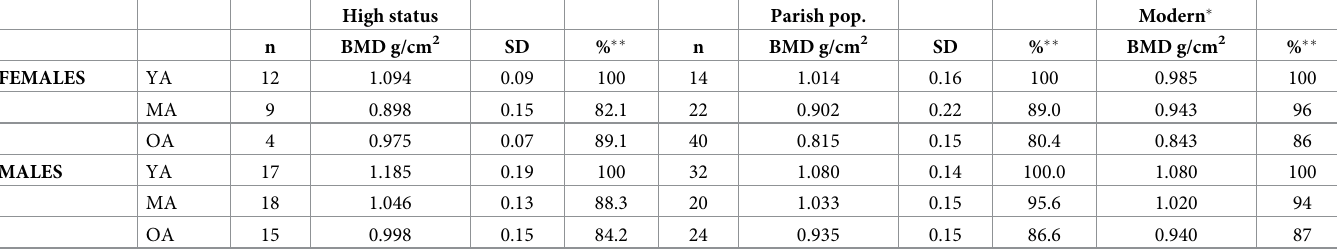
Table 5. Femur neck mean BMD values and SD for each sex, age group, and SES group. High status Parish